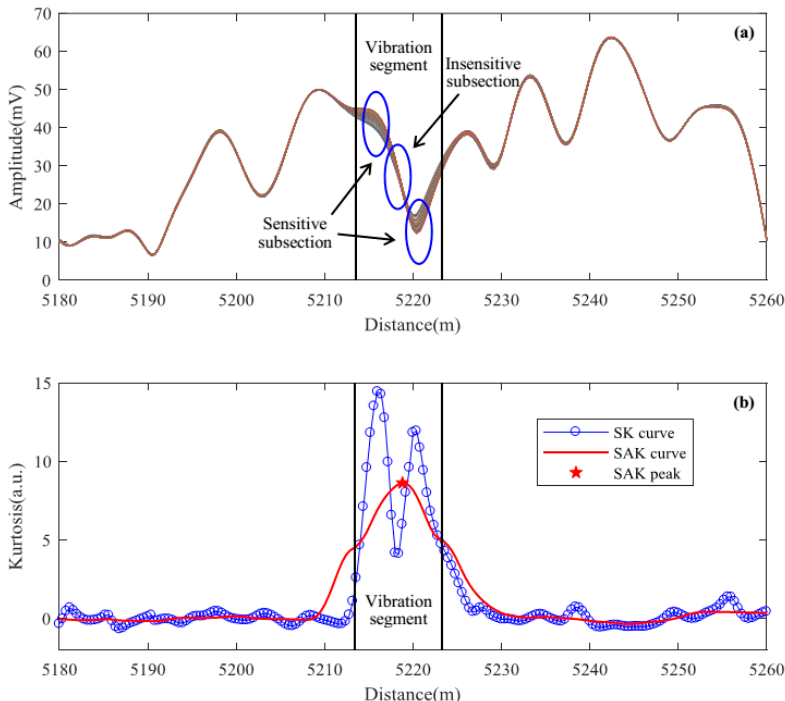
Figure 2. The vibration locating results when coherent fading problem exists. ( a ) 100 averaged Rayleigh traces; ( b ) The spatial kurtosis (SK) and special average kurtosis (SAK) curves of the Rayleigh